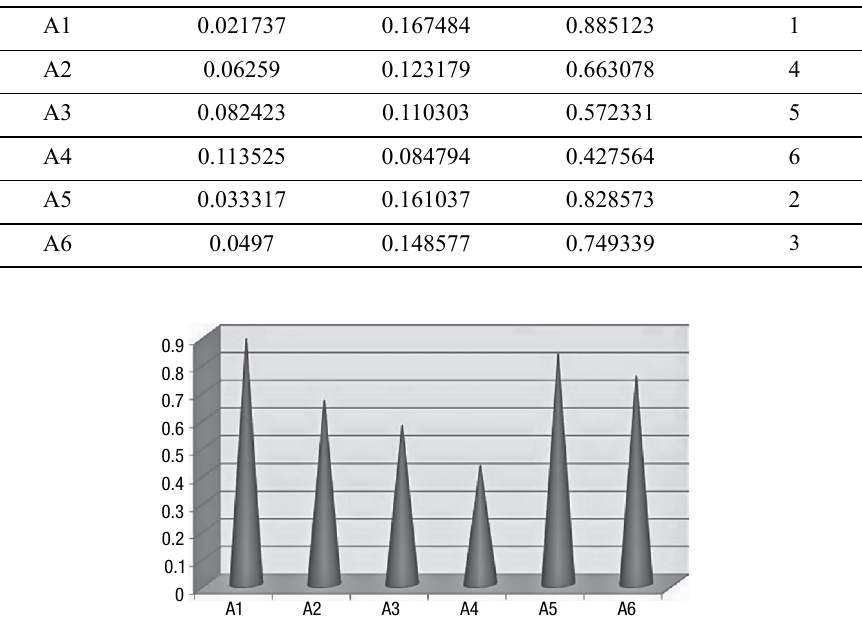
Fig. 7. Ranking of